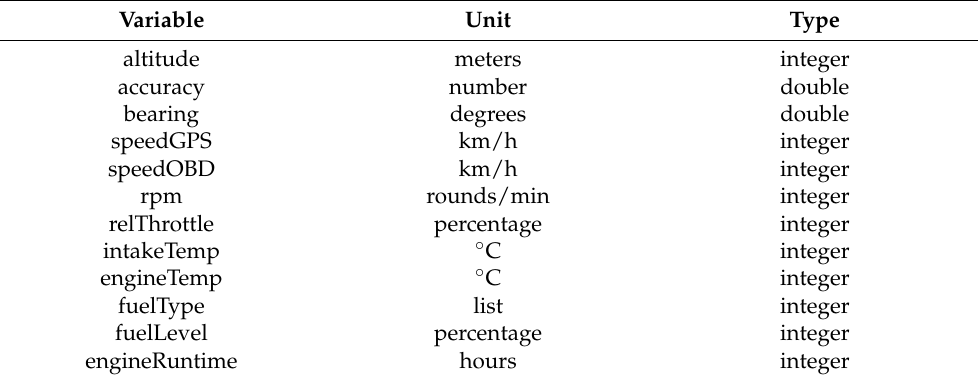
Table 2. Final data structure for each vehicle considering the univariate analysis for outlier